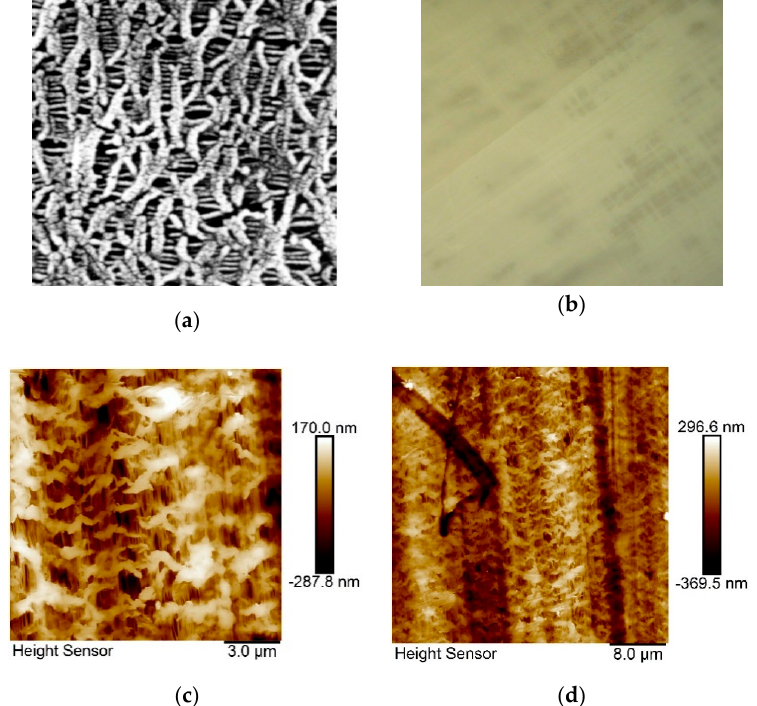
Figure 1. Topographical images of porous polyethylene (PE) film obtained at room temperature: ( a ) by the Scanning Electron Microscopy (SEM) (width of the photo is ~10 µm); ( b ) by the polarizing optical microscopy (POM) under crossed polarizers (width of the photo is ~250 µm) and by Atomic Force Microscopy (AFM) ( c ),( d ) at difference places of the sample under resolution, as indicated. The stretching direction for: ( a ) is horizontal; ( c , d ) vertical.